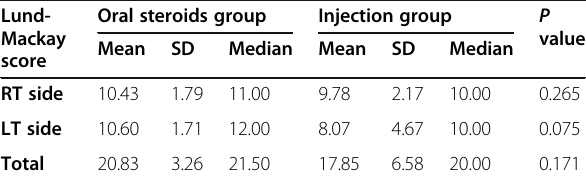
Table 7 Lund-Mackay score before treatment in both groups